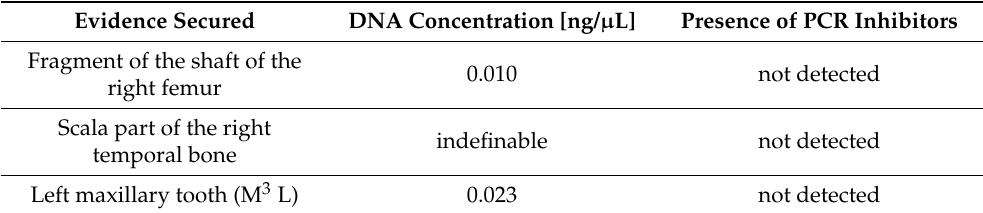
Table 1. Human DNA concentrations in isolates obtained from individual evidence samples. Evidence Secured DNA Concentration [ng/ µ L] Presence of PCR Inhibitors Fragment of the shaft of the 0.010 not detected right femur Scala part of the right indefinable not detected temporal bone Left maxillary tooth (M 3 L) 0.023 not